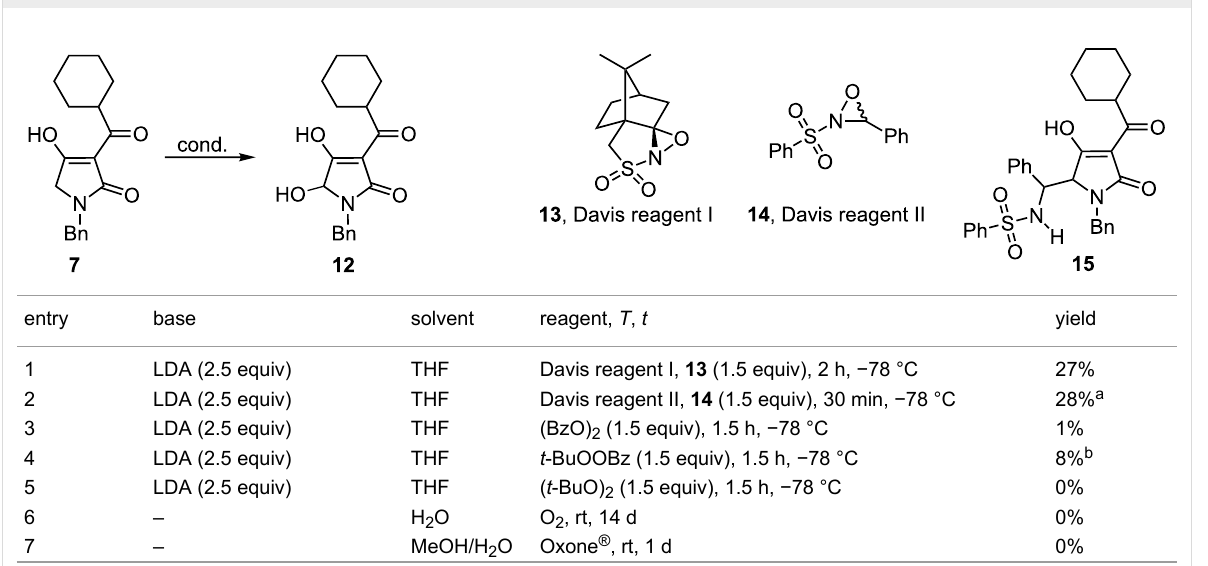
Table 1: Initial study of oxidation of tetramic acid 7 .